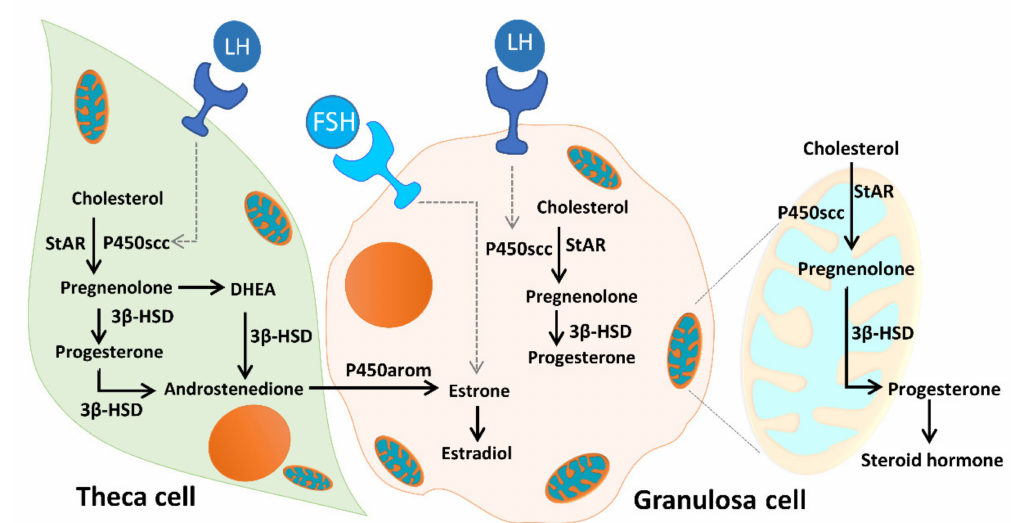
Figure 12. Mitochondrial function in modulating human granulosa cell steroidogenesis and female fertility. Cholesterol transferred from granulosa cells, by low-density lipoprotein (LDL) receptor-mediated endocytosis, into theca cells, where it is used as a substrate for steroidogenesis. The conversion of cholesterol to pregnenolone is initiated by the binding of luteinizing hormone (LH) to the LH receptor (LHR), and subsequent conversion of androgens to E2 is initiated by the binding of follicle-stimulating hormone (FSH) to the follicle-stimulating hormone receptor (FSHR). Mitochondria are the central sites for steroid hormone biosynthesis. The first step in the biosynthesis of steroid hormones is the transfer of cholesterol to the mitochondrial outer membrane, which is facilitated by StAR. Then, cytochrome P450scc (CYP11A1) initiates steroidogenesis by converting cholesterol to pregnenolone at the mitochondrial inner membrane, and the enzyme 3 β -HSD binds with P450scc to form a complex inserted into the mitochondrial inner membrane of the mitochondria to synthesize progesterone. The mitochondrial intermembrane proton gradient is essential for the 3 β -HSD activity. Mitochondrial dysfunction of the human granulosa cells may contribute to the decline of